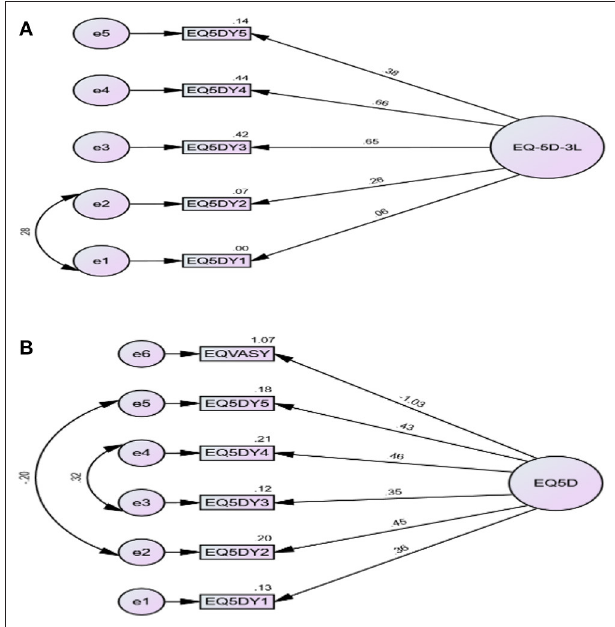
FIGURE 2 | (A,B) Structural equation modeling of EQ-5D -